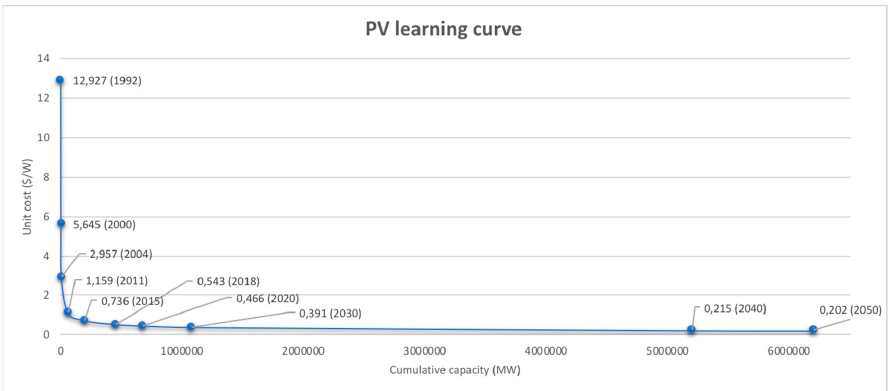
Figure 1. PV learning curve calculated from (1).